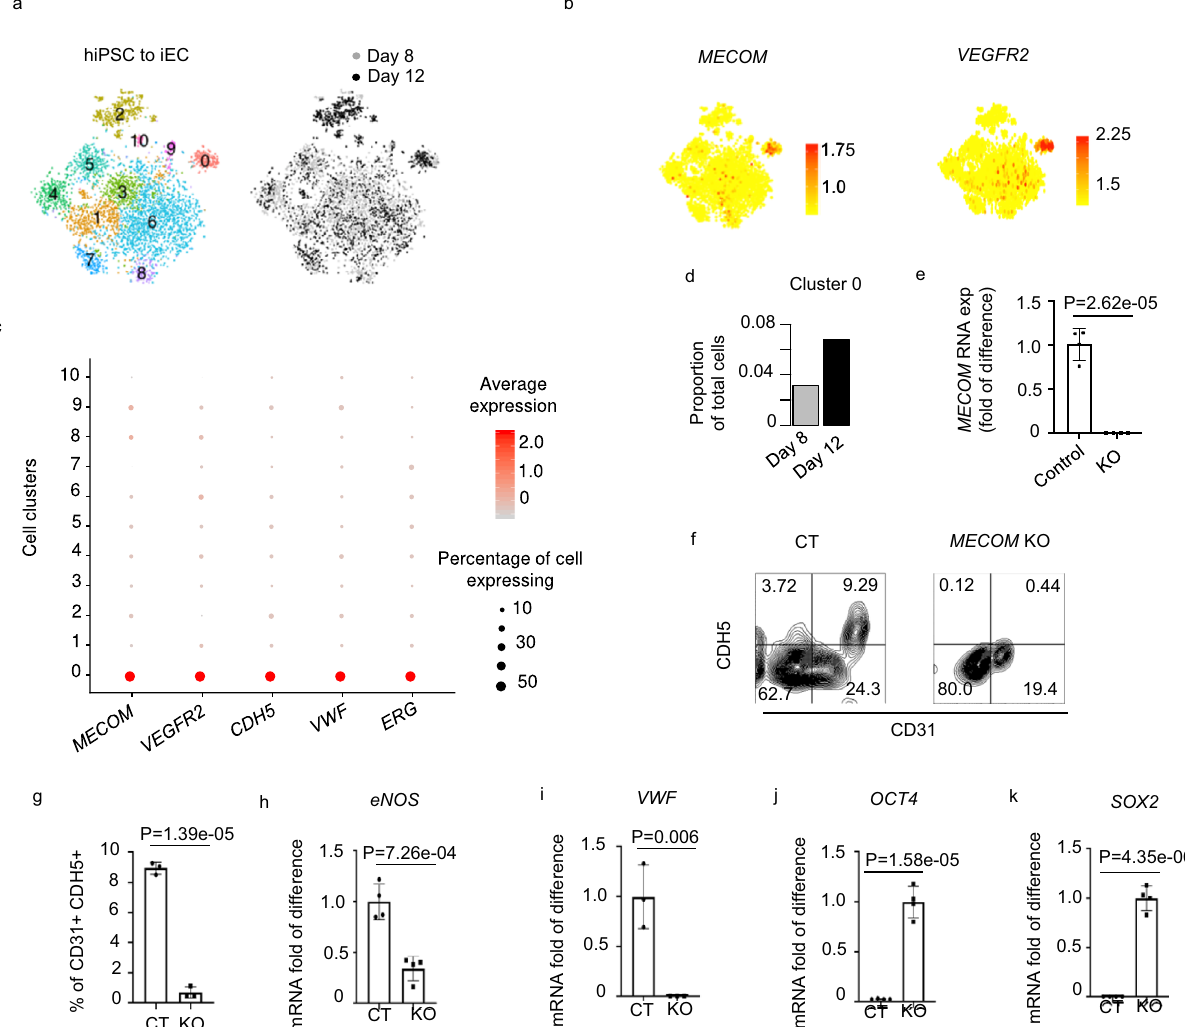
Fig. 2 | MECOM is required for EC differentiation from hiPSC. a – d scRNA-seq analysisreveals MECOM asamolecularsignatureofiPSC-derivedECs.( a )T-SNEplot of combined cells from days 8 and 12 of EC differentiation. 11 cell clusters are de fi ned based on transcriptomic similarity. b , c Expression pro fi les of MECOM and VEGFR2 across 11 individual clusters ( b ) compared with other known EC markers ( CDH5 , VWF , ERG )( c ). d Proportionofcellsassignedtothe MECOM positivecluster 0 on day8 and day 12. e – k Experimentalveri fi cation of MECOM as a lineage factor